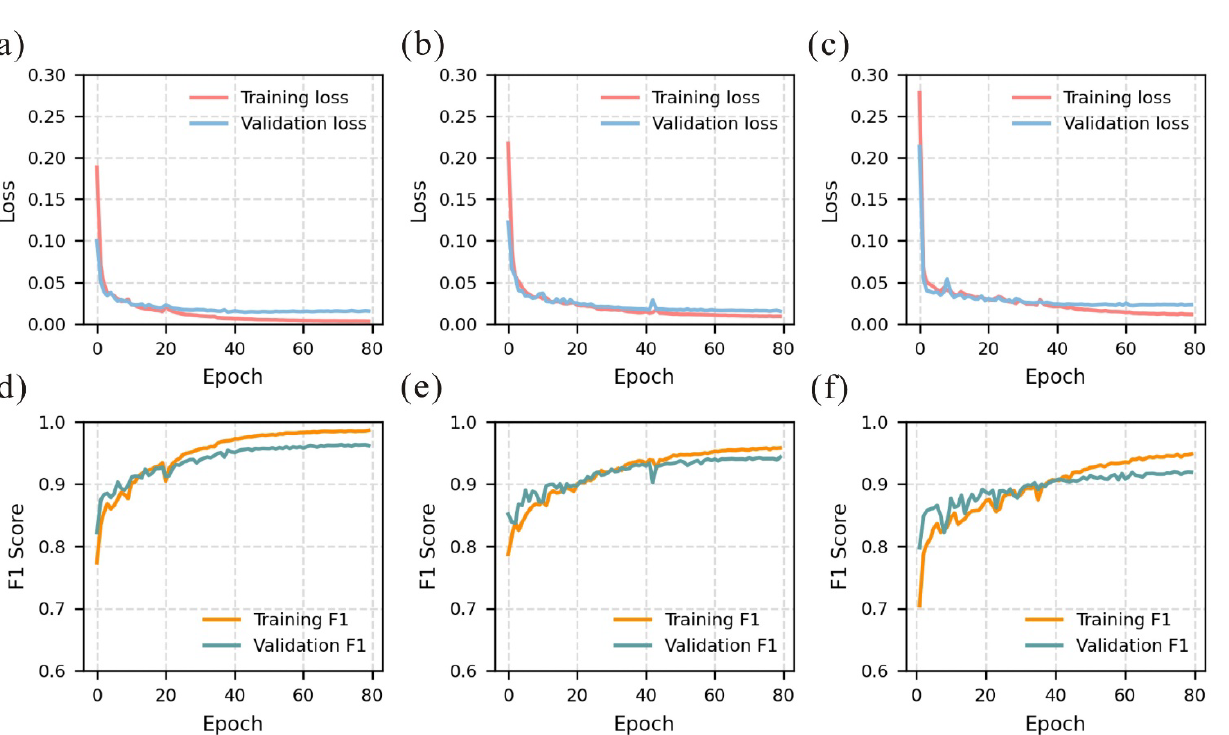
Table 3. Evaluation of the active landslides extraction results on the test dataset.